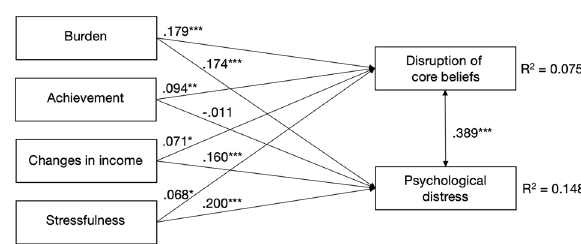
Fig. 1 Resulting model of the path analysis. All coef fi cients are standardized partial regression coef fi cients. Levels of signi fi cance: preventive measures, Achievement achievement of preventive measures, Changes in income changes in income due to the pandemic, Stressfulness stressfulness of the